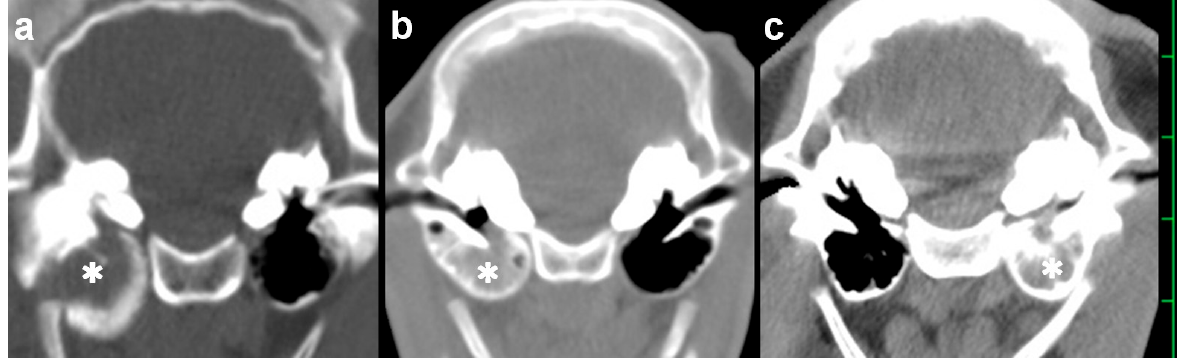
Figure 1. Transverse computed tomography of the skull examined preoperatively (( a ) Case 1; ( b ) Case 2; and ( c ) Case 3). The hyperattenuating materials (asterisk) are seen within the tympanic cavity. The scale is 25 mm.